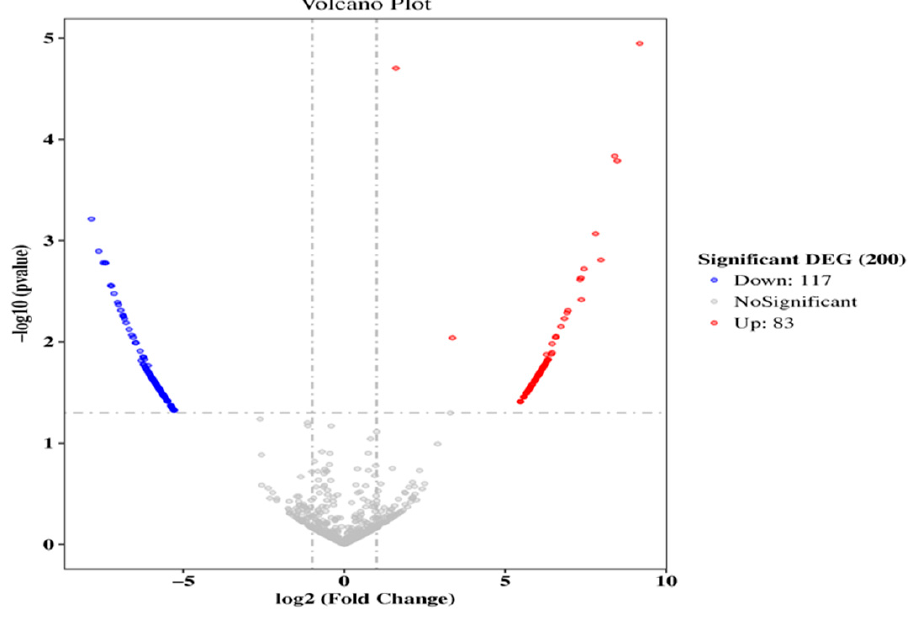
Figure 4. Differentially expressed circular RNAs in healthy and endometritis mouse. Blue means down-regulation, red means up-regulation, grey means not significant.